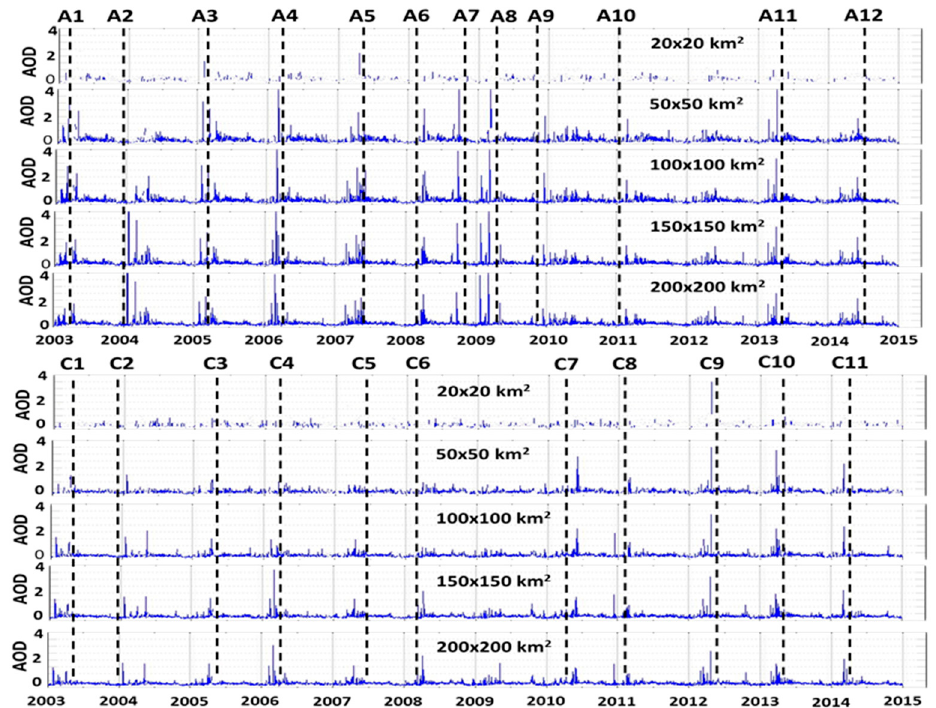
Figure 7. Daily time series of AOD from year 2003 to 2014 for different square domains centered over Alexandria ( top ) and Cairo ( bottom ). The domain is identified by its dimensions (see Figure 6). Selected severe air pollution events are marked by vertical dashed lines and labeled for Alexandria (A) and Cairo (C).